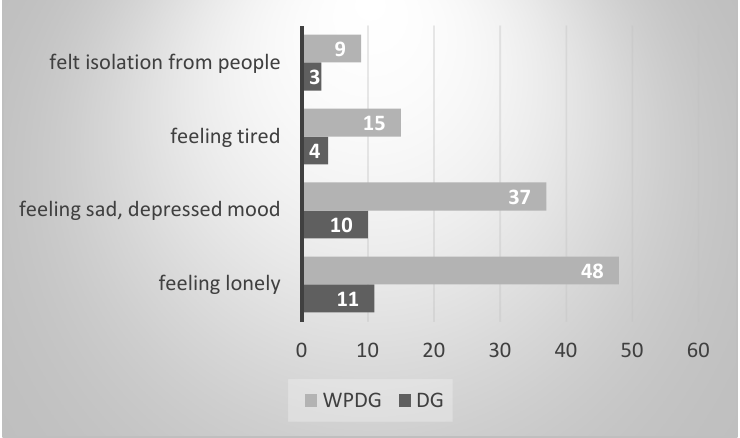
Figure 2. Examples of the most frequent feelings (N) described as deterioration in well-being adolescents.